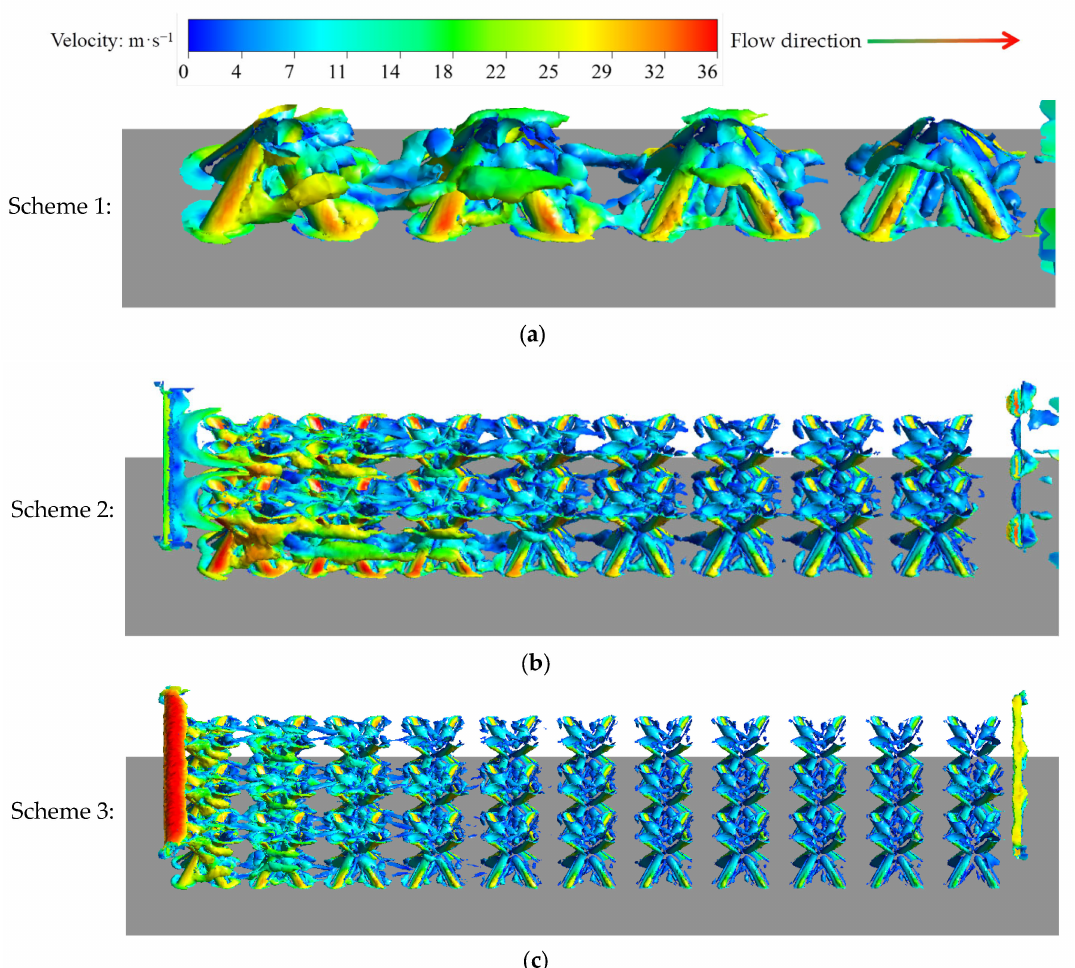
Figure 4. Flow field distributions in X-shaped truss array channels at different layout schemes ( Re = 30,000): ( a ) Scheme 1; ( b ) Scheme 2; ( c ) Scheme